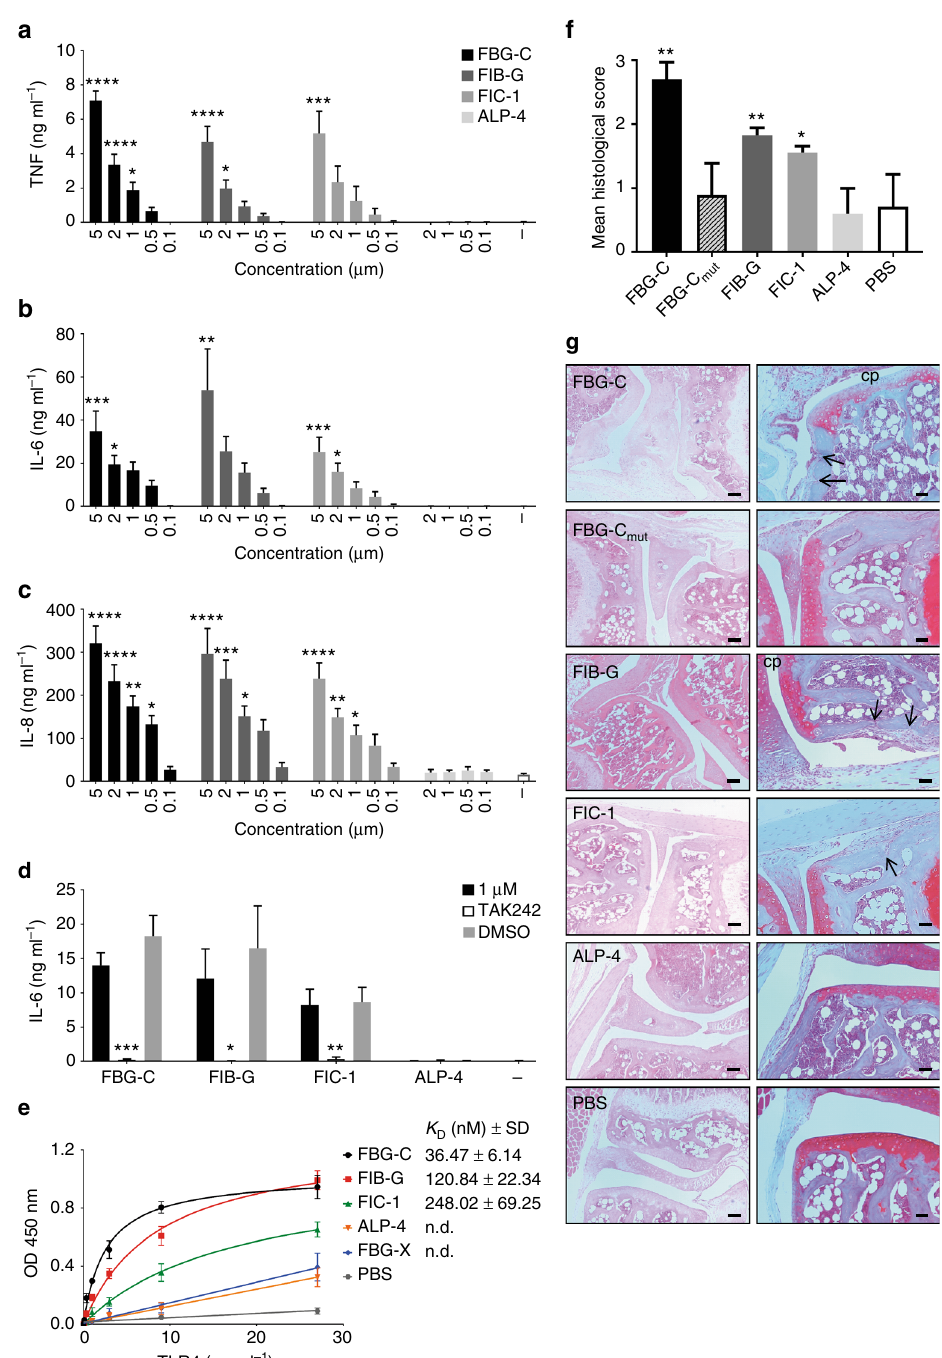
Fig. 7 The FBG domains of FIB-G and FIC-1 exhibit pro-in fl ammatory effects in vitro and in vivo. a – c Primary human macrophages were stimulated with different concentrations of FBG-C, FIB-G, FIC-1, and ALP-4, or were left unstimulated ( − ) for 24 h. Cytokine levels were measured by ELISA. Data shown as mean ± SEM from at least three independent donors. One-way ANOVA vs. non-stimulated, * p < 0.05, ** p < 0.01, *** p < 0.001, **** p < 0.0001. d Primary human macrophages were pre-incubated for 6 h with 3 µ M TAK 242 prior to stimulation with FBG-C, FIB-G, FIC-1, and ALP-4 (1 µ M), or no stimulation ( − ) for 24 h. Cytokine synthesis was measured by ELISA. Data shown as mean ± SEM from at least three independent donors. Paired t -test vs. non-treated, * p < 0.05, ** p < 0.01, *** p < 0.001. e 96-well plates were coated with 1 µ g ml − 1 of FBG-C, FBG-X, FIB-G, FIC-1, and ALP-4, or PBS, and incubated with increasing doses of TLR4. Curves were fi tted in GraphPad Prism using one-binding site hyperbola equation. Data are shown as mean ± SEM from three independent experiments. f , g Synovial in fl ammation was assessed 3 days post injection of each protein (1 µ g) or PBS alone into the knees of DBA-1 mice. The histological score was calculated as the mean of seven sections from each knee joint per mouse. n = 5 mice per group except for FIC-1 ( n = 4) ( f ). Mann – Whitney non-parametric test vs. PBS, * p < 0.05, ** p < 0.01. Images show representative sections stained by haematoxylin and eosin (left panels) or safranin-O (right panels) ( g ). Mice injected with FBG-C, FIB-G, and FIC-1 exhibit cell in fi ltration into a thickened synovial lining layer, cellular invasion into the subchondral bone (arrows indicate bone erosion) and loss of articular cartilage proteoglycan (cp), pathological features not observed in mice injected with FBG-C mut or ALP-4.Scale bar left panels: 100 μ M, right panels: 50 μ